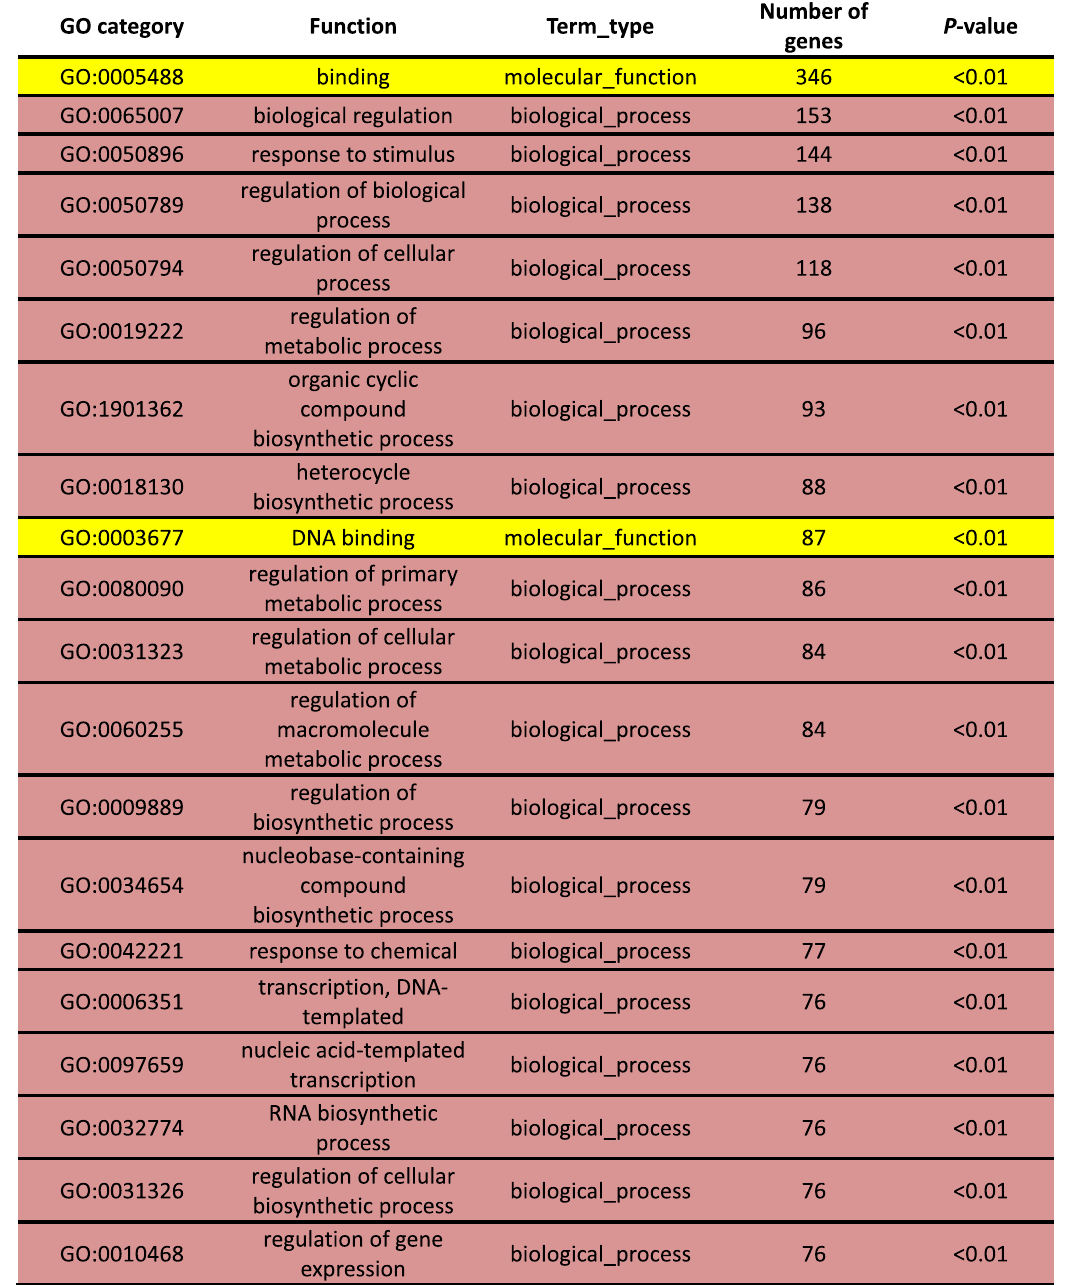
Table 3 Gene ontology (GO) classification of the differentially expressed genes (DEGs) derived from the ‘ Cp+R vs. Cp ’ comparison. Cp + R, Rhizoglomus intraradices -inoculated cultivated rice infected with Magnaporthe oryzae ; Cp, R. intraradices -uninoculated cultivated rice infected with M.